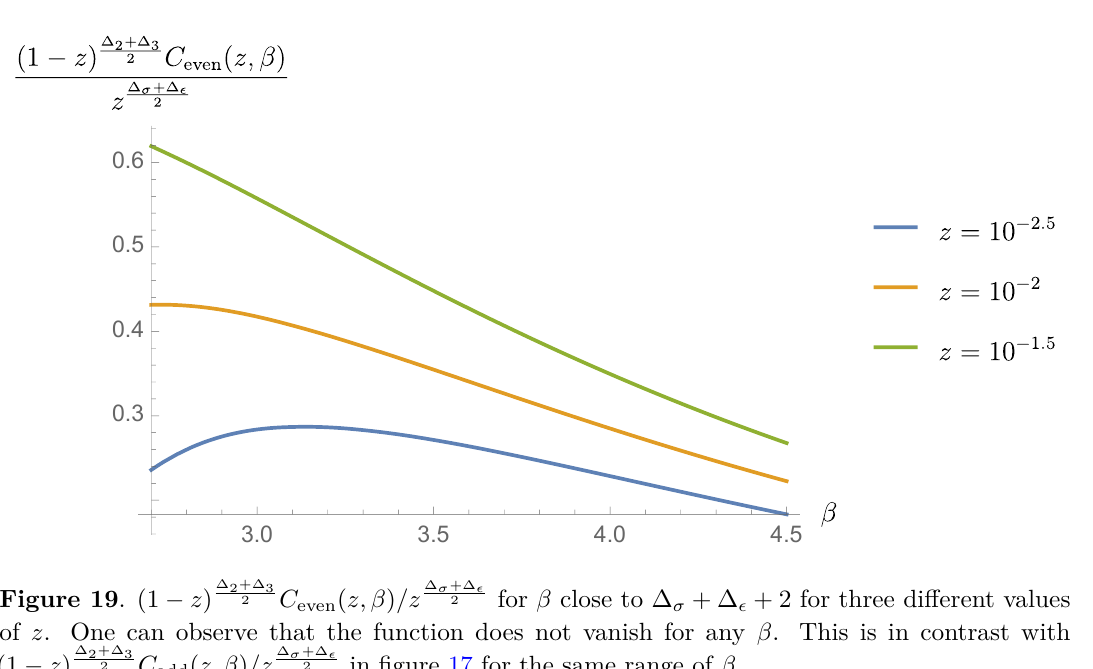
Figure 19 . (1 − z ) ∆2+∆3 2 C even ( z, β ) /z ∆ σ +∆ (cid:15) 2 for β close to ∆ σ + ∆ (cid:15) + 2 for three different values of z . One can observe that the function does not vanish for any β . This is in contrast with (1 − z ) ∆ 2 +∆ 3 2 C odd ( z, β ) /z ∆ σ +∆ (cid:15) 2 in figure 17 for the same range of β